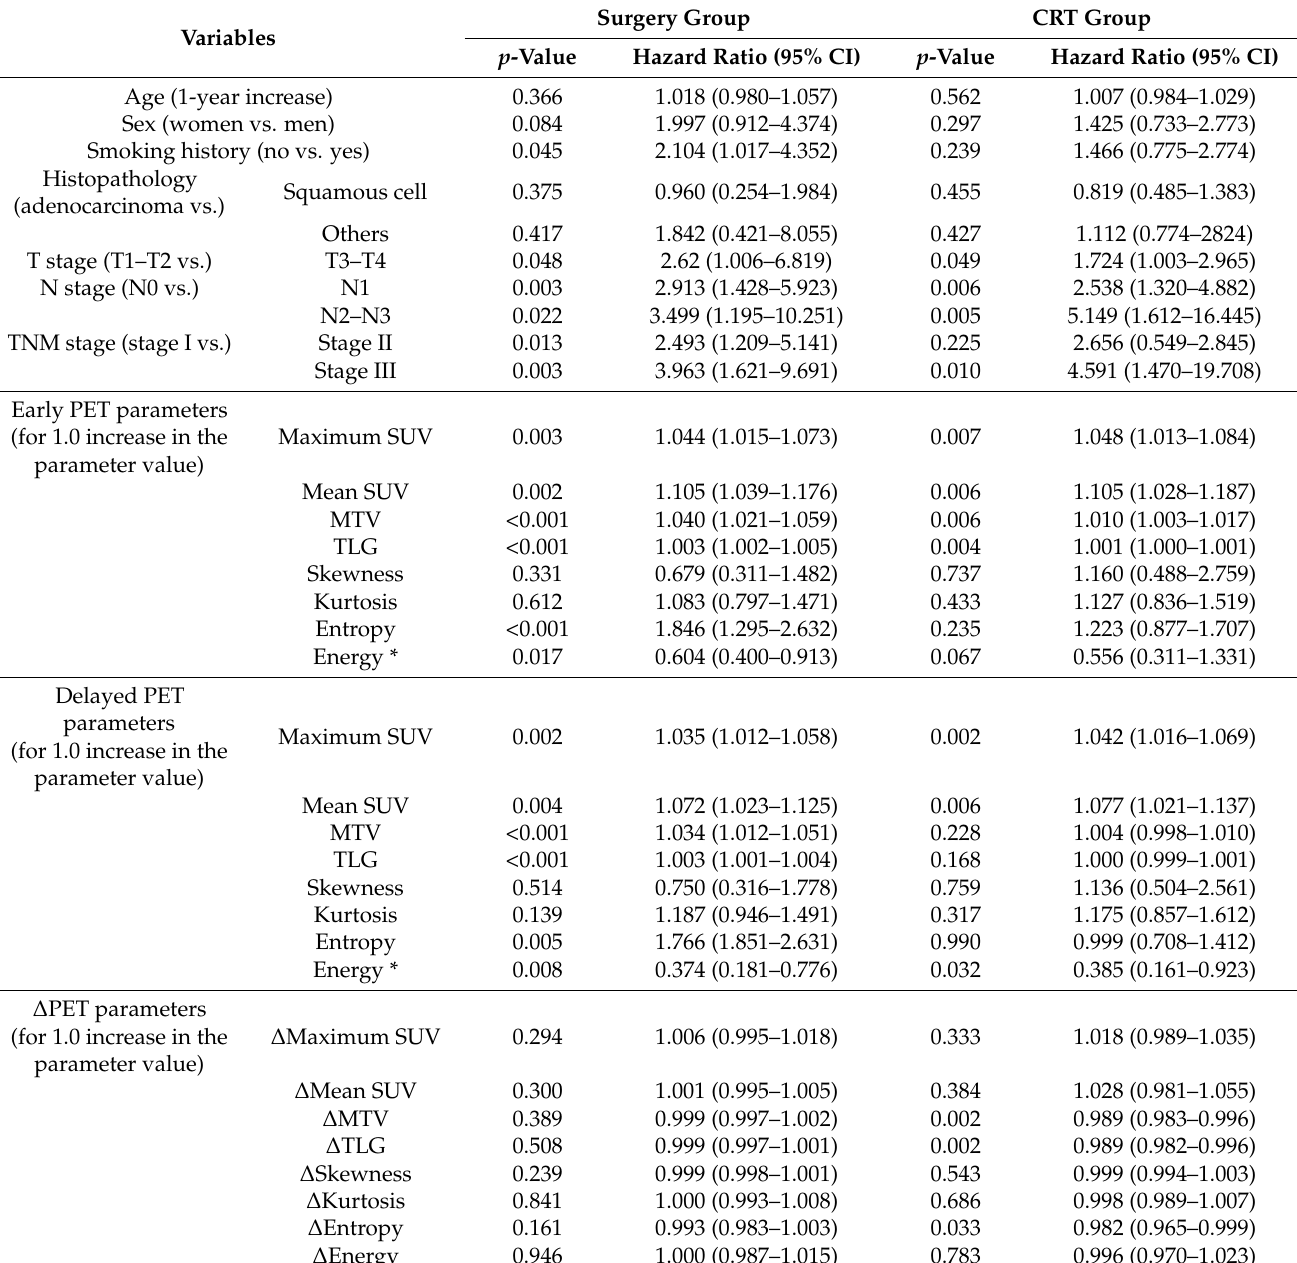
Table 3. Univariate survival analysis of PFS in the surgery group (n = 121) and CRT group (n =